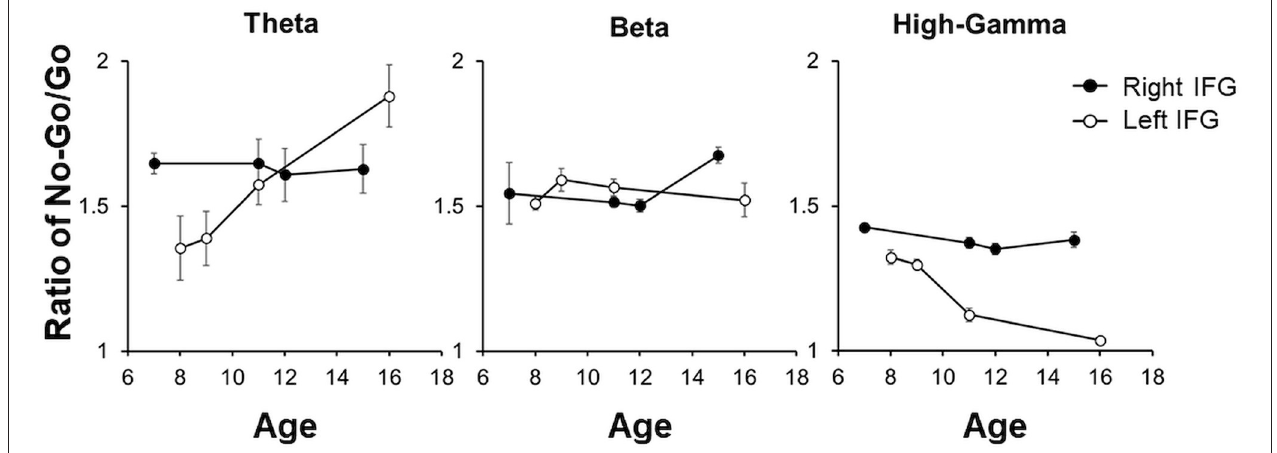
FIGURE 8 | The power ratios between No-Go/Correct and Go/Correct in theta, beta, and HG were illustrated by mean ± 95% CI in each patient. For the patients with the right IFG coverage, there was no obvious change by age. For the left IFG, there was a decreasing trend in HG by age as well as an increasing trend in theta, but no obvious pattern was noted in the ratio of